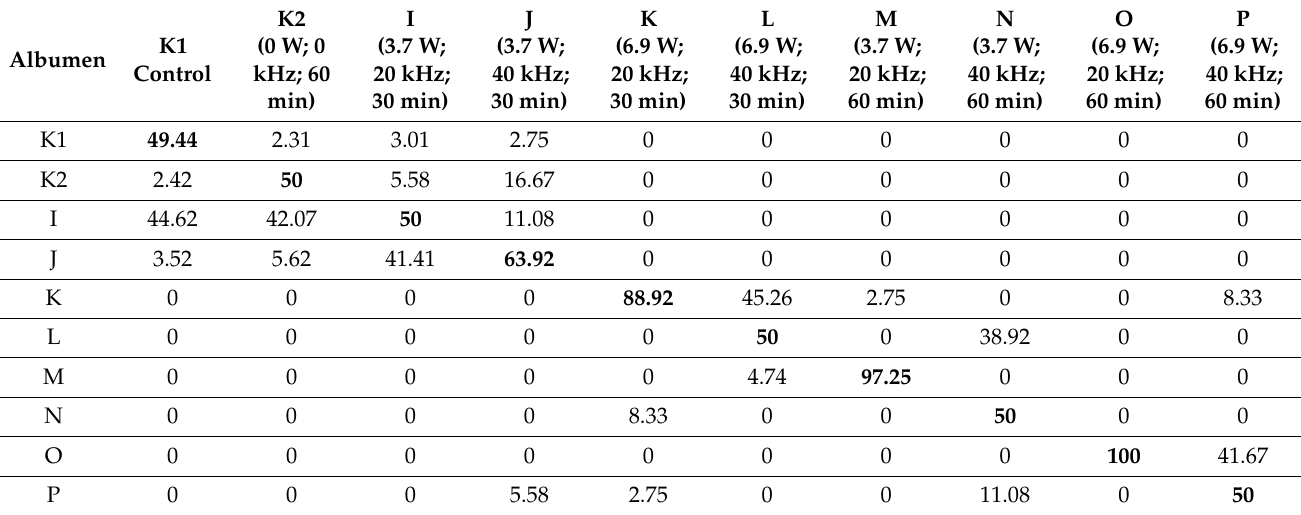
Table 4. Classification accuracy of linear discriminant analysis of albumen samples, %.